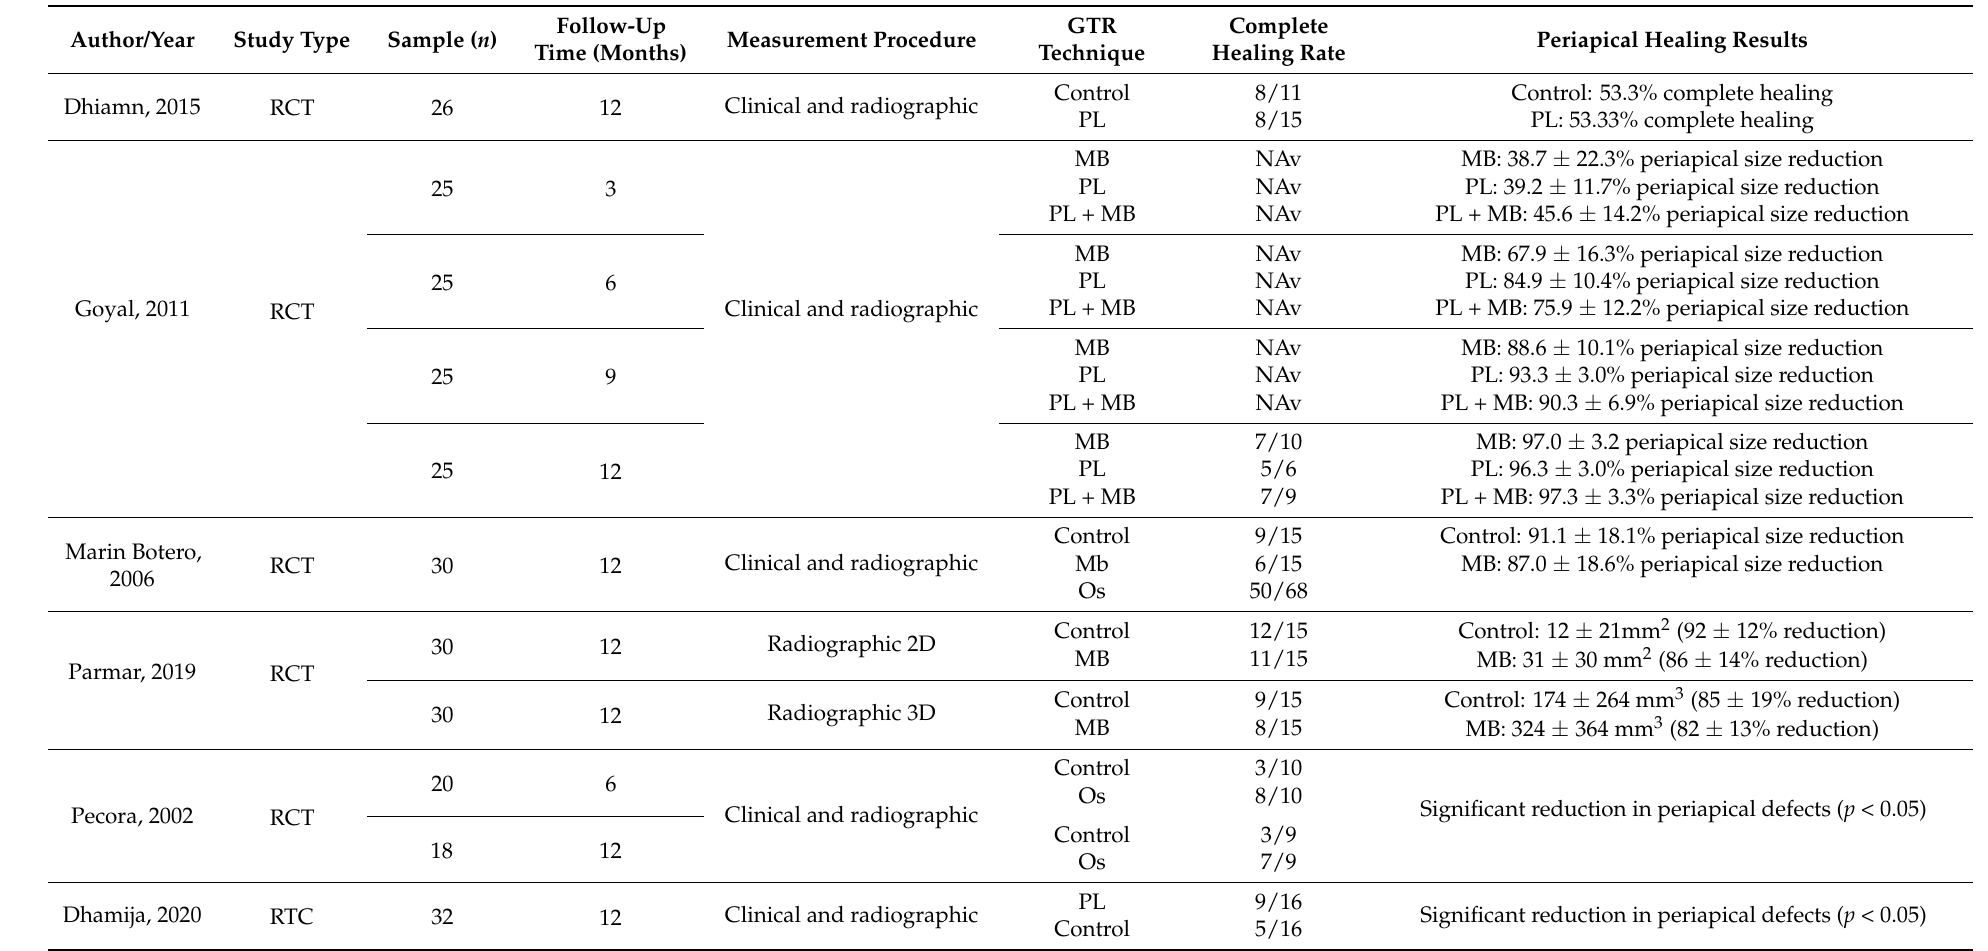
Table 2. Qualitative analysis of articles included in systematic